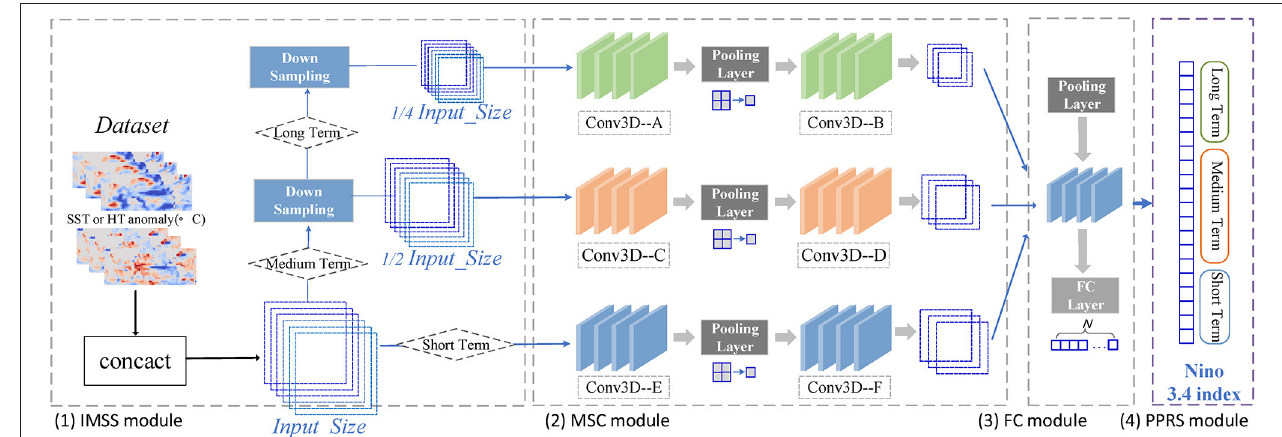
FIGURE 3 | The architecture of the MS_CNN model. (1) Input mesh size selection (IMSS) module aims to increase the input mesh size as the prediction lead time lengthened. (2) Multi-term swappable convolution (MSC) module is mainly to adjust the appropriate receptive field expansion. (3) Fully connected (FC) module transforms the feature map of CNN to vector, and then output the prediction of Nino 3.4 index. (4) Parallel prediction result splicing (PPRS) module splices the Nino 3.4 index of each lead time at the parallel network.